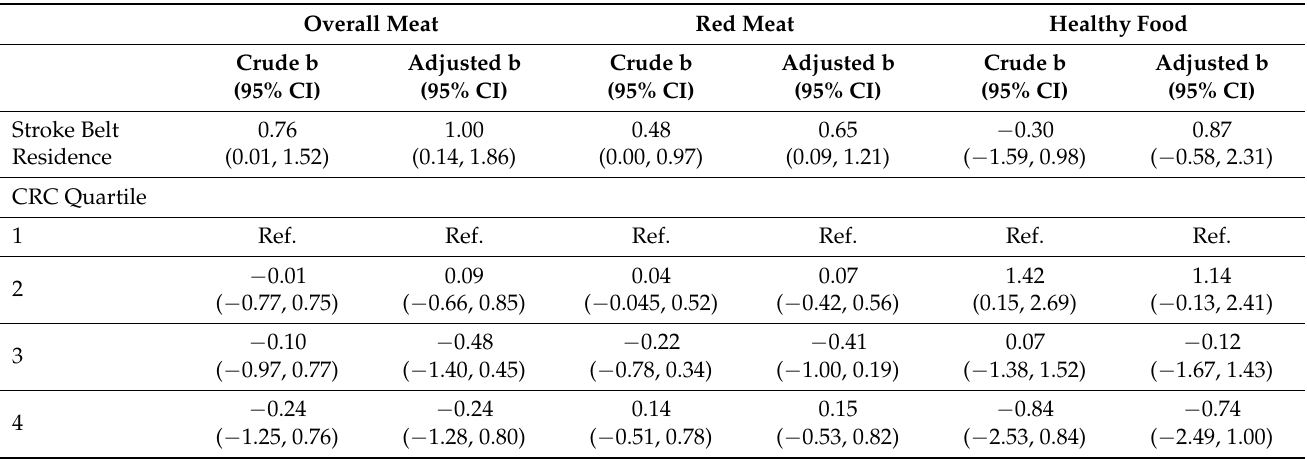
Table 3. Relationship between Stroke Belt residence, colorectal cancer incidence group, and food